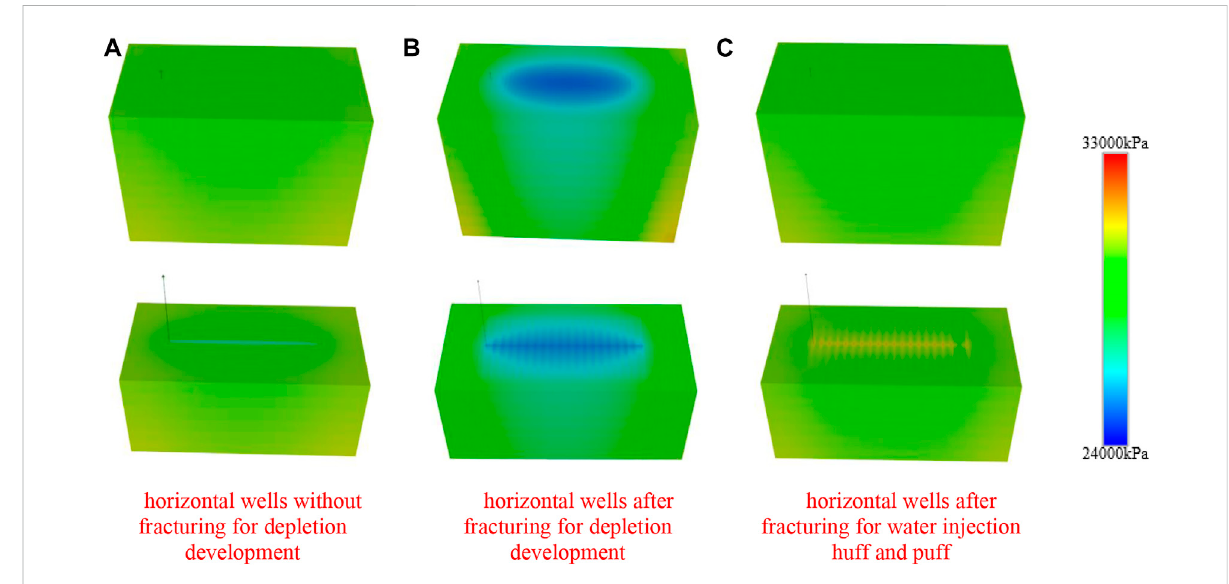
FIGURE 6 Pressure distribution under different development methods in metaphase